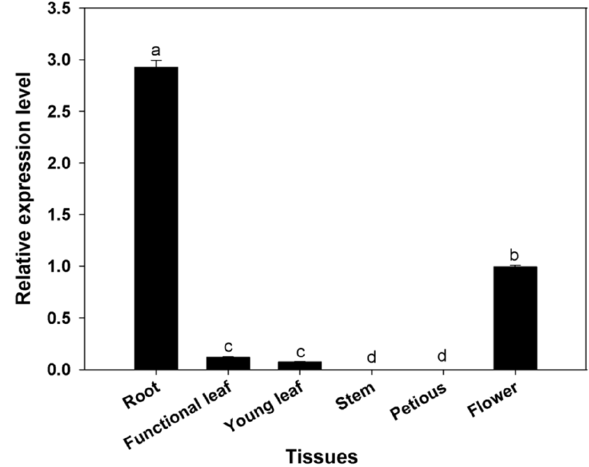
Figure 4. BcAMT1;5 expression patterns in different organs of flowering Chinese cabbage. Each value shows the mean ± SE ( n = 3 ). Different lowercase letters show significant differences at p < 0.05.